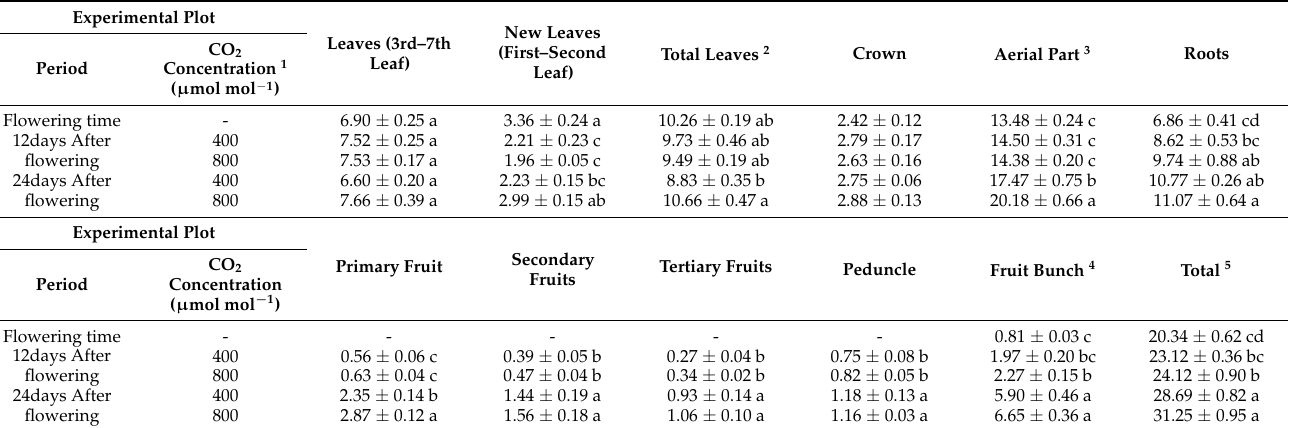
Table 3. Effects of different concentration of CO 2 enrichment on dry matter weight of each part of strawberry ‘Sagahonoka’.